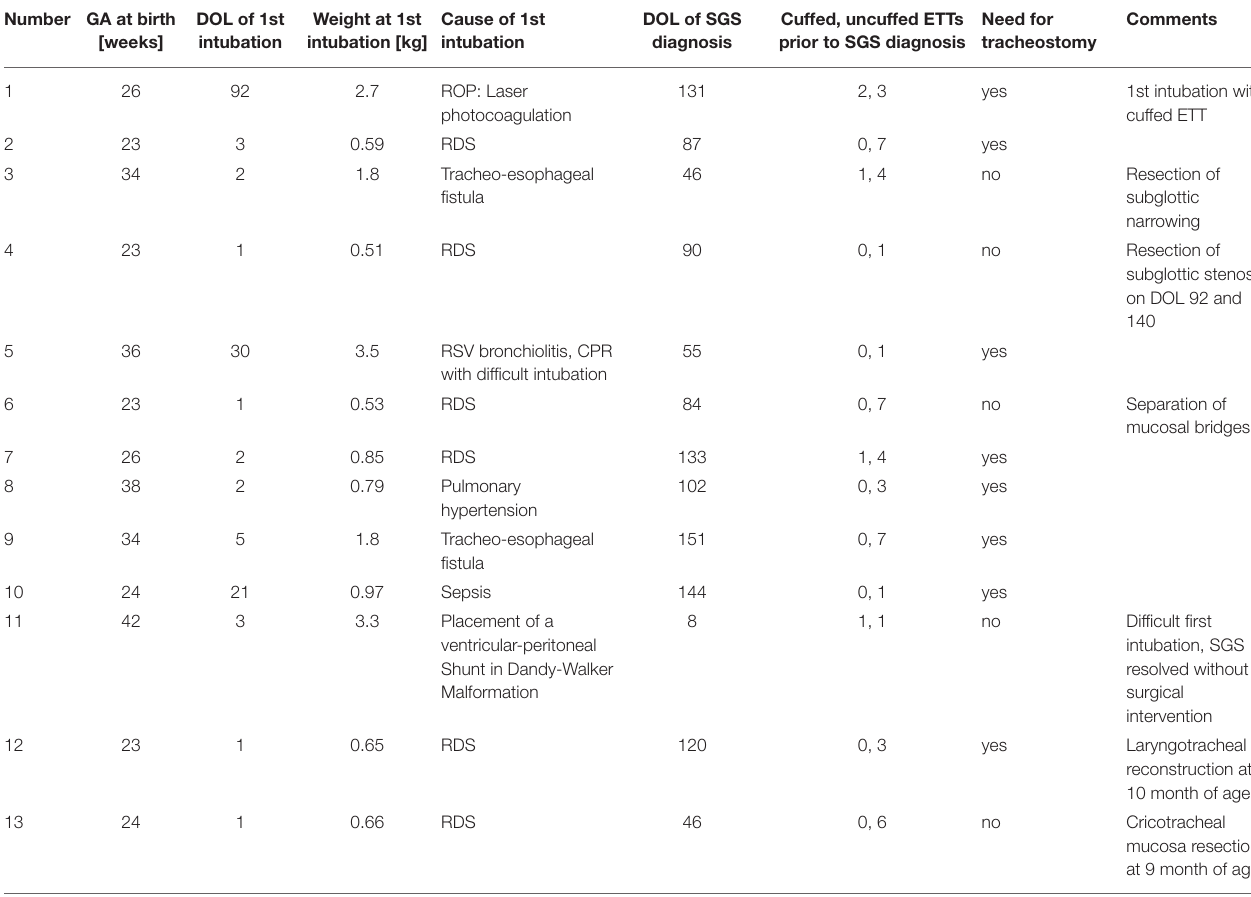
TABLE 3 | Characteristics of infants who developed a subglottic stenosis (SGS) needing a laryngeal intervention. Number GA at birth DOL of 1st Weight at 1st Cause of 1st [weeks] intubation intubation [kg] intubation